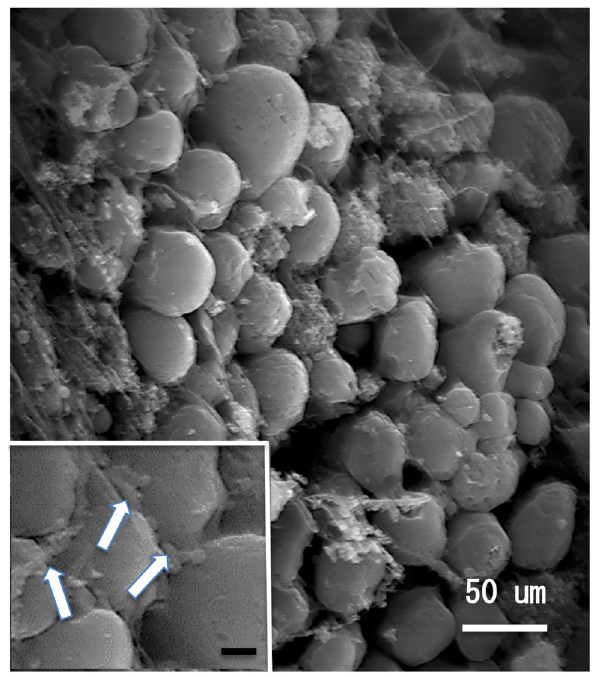
Figure 2. Scanning electron microscopic image of diatoms in the intestine of Andamia tetradactylus . Inset: The club-shaped bacteria (arrows) were seen on the surfaces of diatoms. Bar = 20